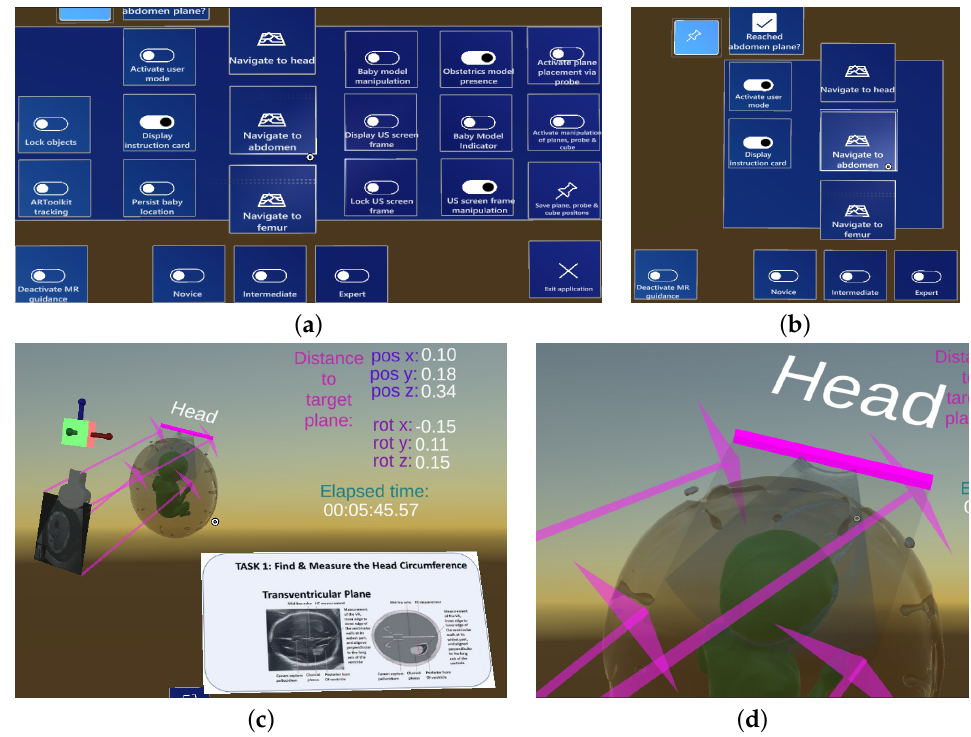
Figure 2. Unity scene showing the various components of the holographic setup: ( a ) complete holographic menu for experts; ( b ) reduced holographic menu for the trainee; ( c ) navigation to head standard plane including the navigation instruction card, navigation arrows, position and rotation offset between probe and target plane and elapsed time for the navigation task; and ( d ) closeup of the head ultrasound plane including the four pink guidance arrows pointing at the plane’s